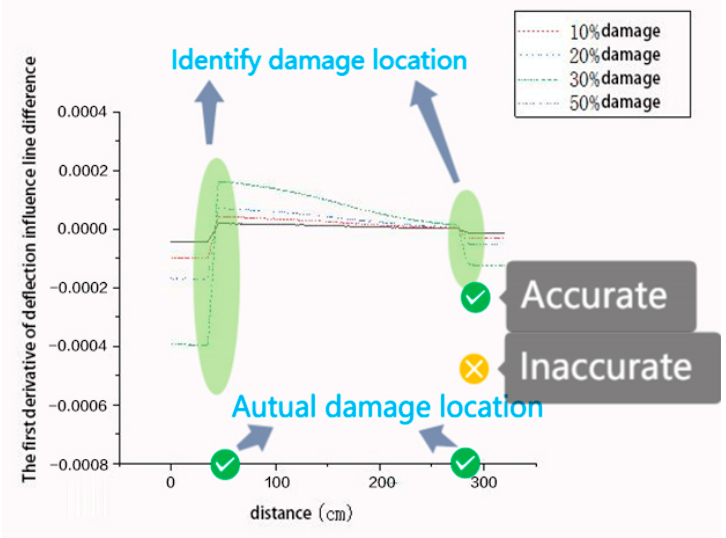
Figure 19. The 1st derivative of deflection influences line difference at 1/4 determining point of the 1st span under work condition 1 (2-5).